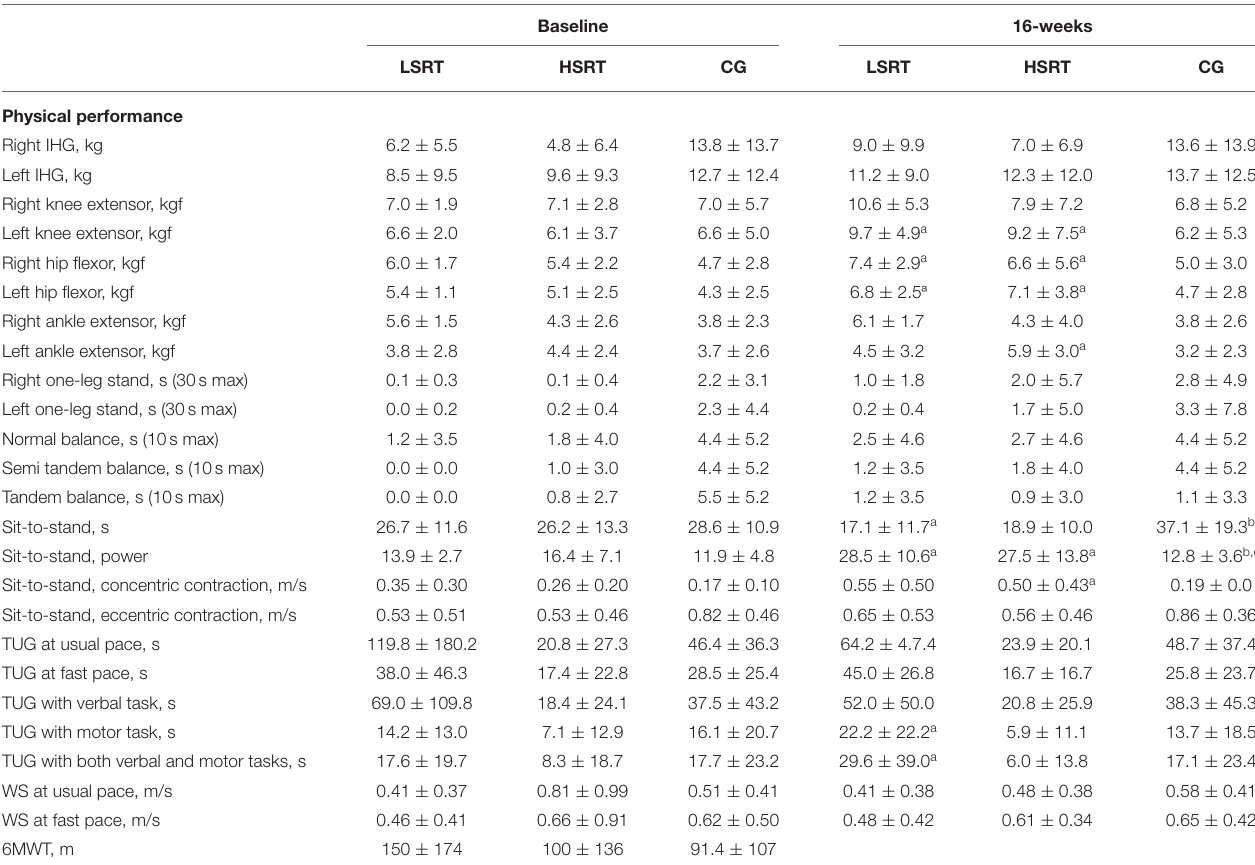
TABLE 3 | Effects of resistance training on physical performance of frail older